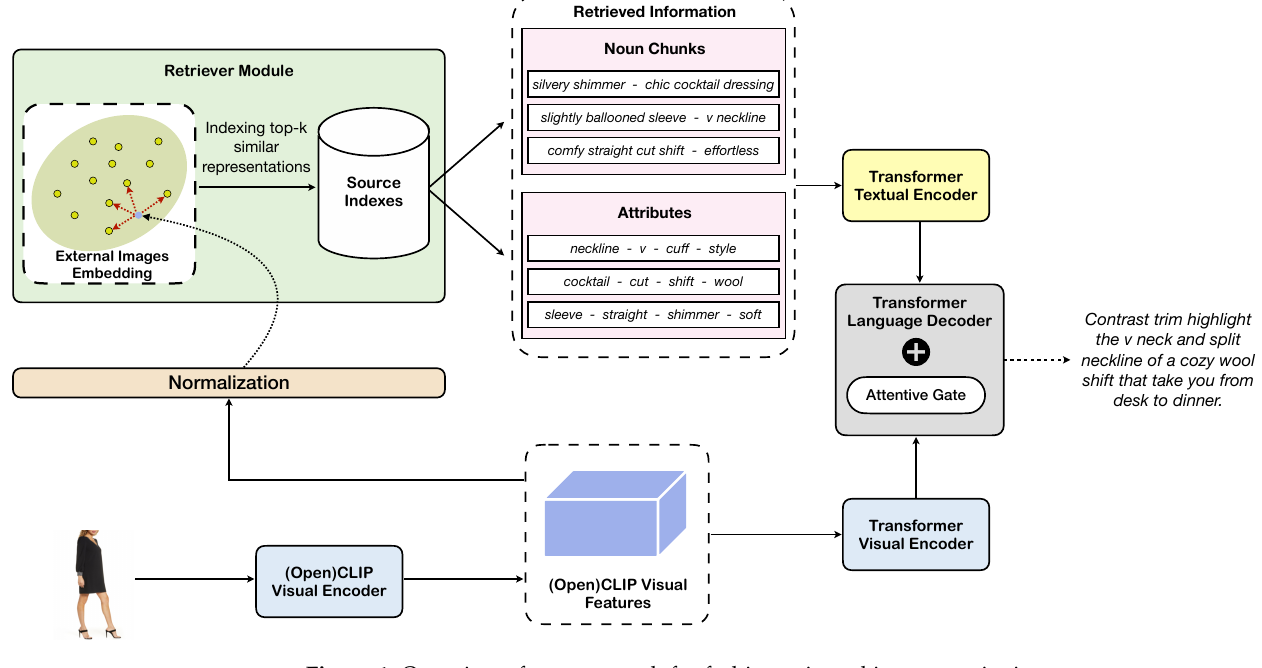
Figure 1. Overview of our approach for fashion-oriented image